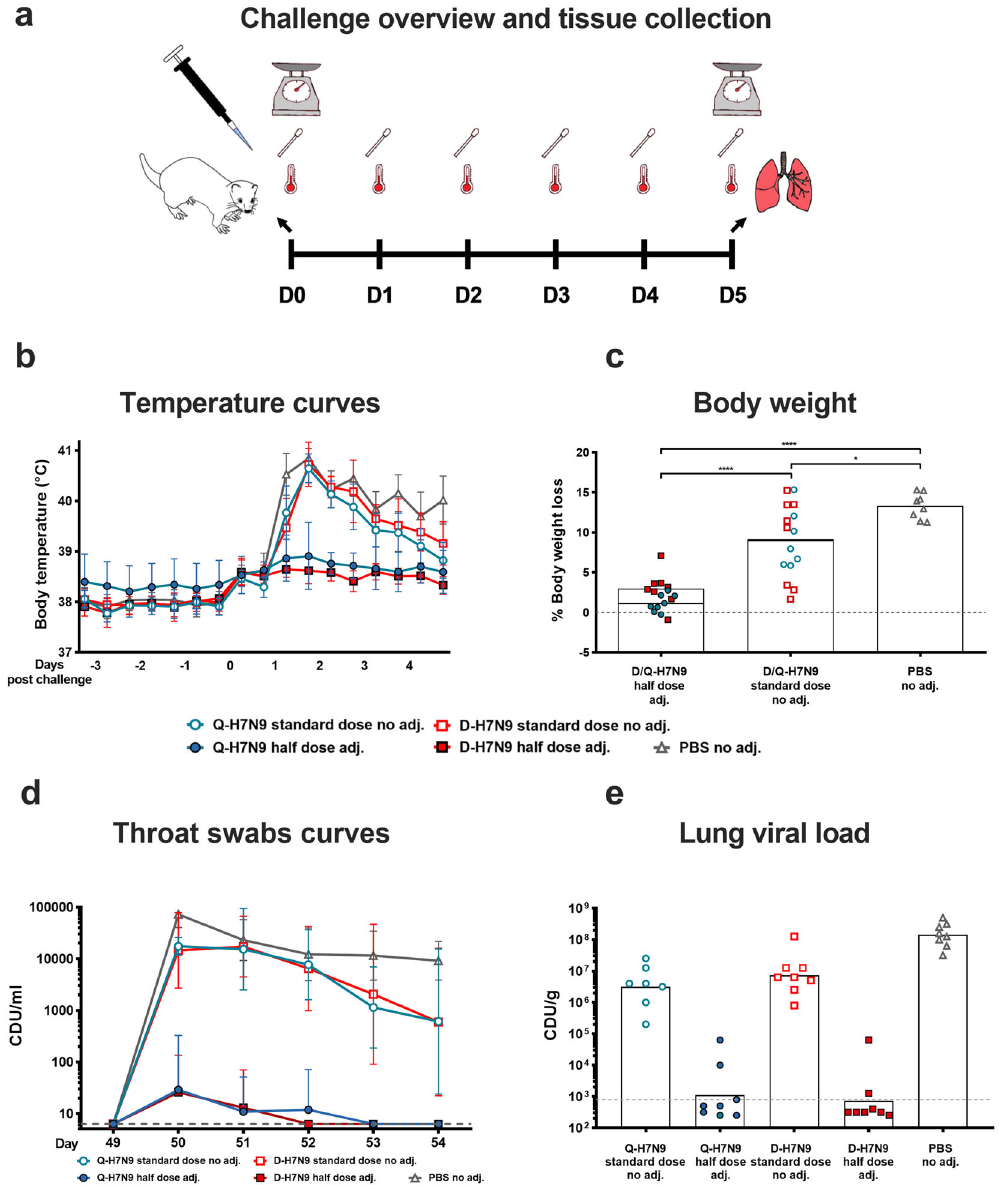
Fig. 5 Challenge experiment overview, morbidity, and viral titers. a Experimental overview. On day 0 (day 49 post-prime) ferret body temperatures and body weights were measured, and throat and nose swabs taken. The body temperatures were monitored continuously with a 10 min interval until the scheduled day of euthanasia (day 5 post-challenge) and nose and throat swabs were collected daily. On day 5 the body weights were recorded, and the animals were euthanized. Nasal turbinates and lungs were collected for virus quanti fi cation and histopathology. b Temperature curves. Body temperature curves (in °C) starting three days before virus challenge until the day of euthanasia (day 5 post-challenge) are shown for the animals receiving non-adjuvanted standard-dose H7N9 split virion vaccines (open circles, open squares), AS03-adjuvanted half-dose H7N9 split virion vaccines (closed circle, closed squares) or PBS (open triangle). The geometric mean of the body temperature of the ferrets per group and geometric standard deviation are shown. c Body weight loss. The body weight at the day of challenge (day 0) and day of euthanasia (day 5) were recorded and the weight loss (in %) plotted on the y -axis. The half-dose, standard dose, and PBS groups were compared in a one-way ANOVA Tukey ’ s multiple comparisons test, * P < 0.0332, **** P < 0.0001. d Throat swab curves. Quanti fi cation of viral RNA by PCR expressed as CDU/mL is depicted for the fi ve different groups (day 0 – day 5). The geometric mean of the CDU/mL and geometric standard deviation are shown. e Lung viral load. Lung viral titers recorded as CDU/g lung tissue is plotted on the y -axis. All samples with a value smaller than the value indicated by the dashed gray line fall below the limit of